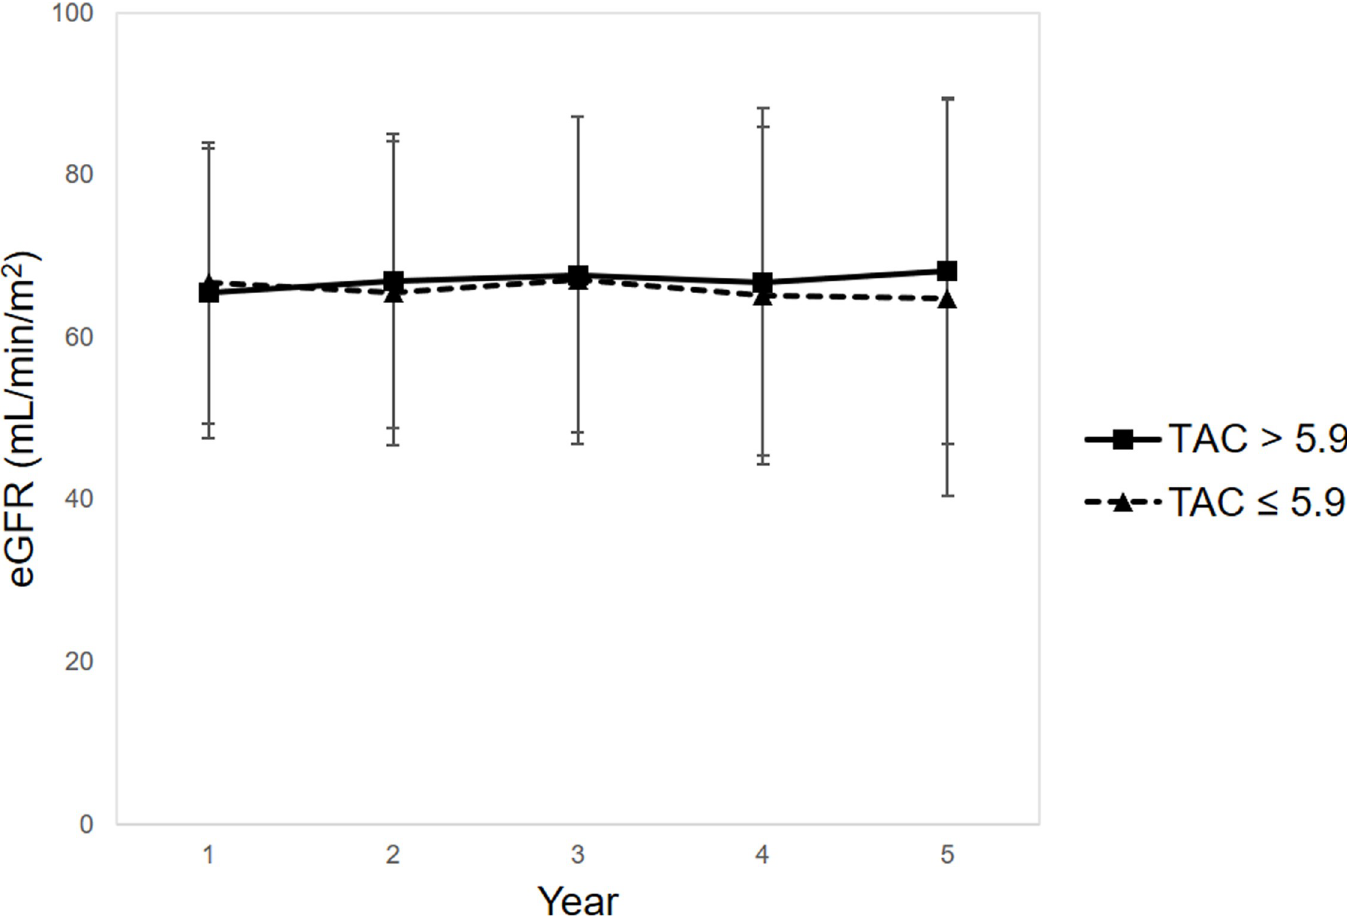
Fig 4. eGFRs at 2, 3, 4, and 5 years post-transplant. There were no significant differences in eGFRs at 2 years (67.0 ± 18.1 vs. 65.5 ± 18.8 mL/min/1.73 m 2 , P = 0.648), 3 years (67.8 ± 19.4 vs. 67.1 ± 20.2 mL/min/1.73 m 2 , P = 0.662), 4 years (66.9 ± 21.4 vs. 65.2 ± 20.8 mL/min/1.73 m 2 , P = 0.417), and 5 years (68.3 ± 21.3 vs. 64.9 ± 24.4 mL/ min/1.73 m 2 , P = 0.273) between the HL-TAC and LL-TAC groups. Abbreviations: eGFR, estimated glomerular filtration rate; LL, low-level; HL, high-level; TAC,